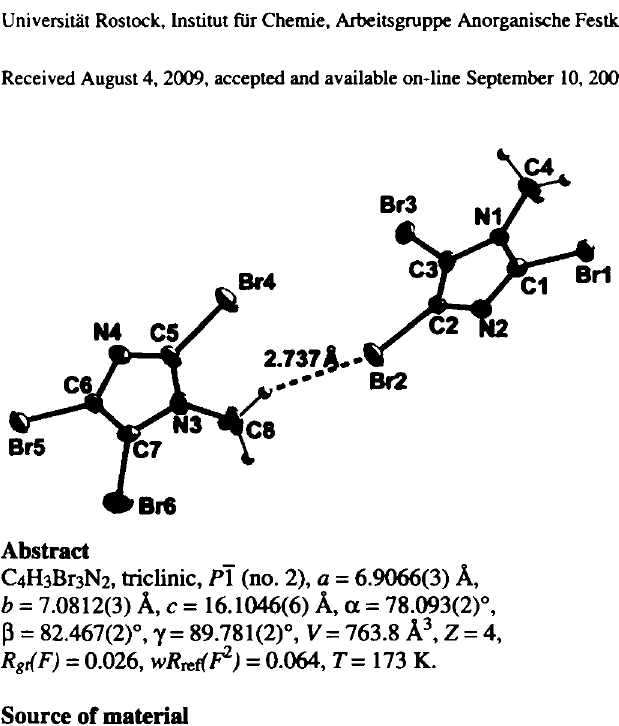
Table 2. Atomic coordinates and displacement parameters (in Â 2 ).